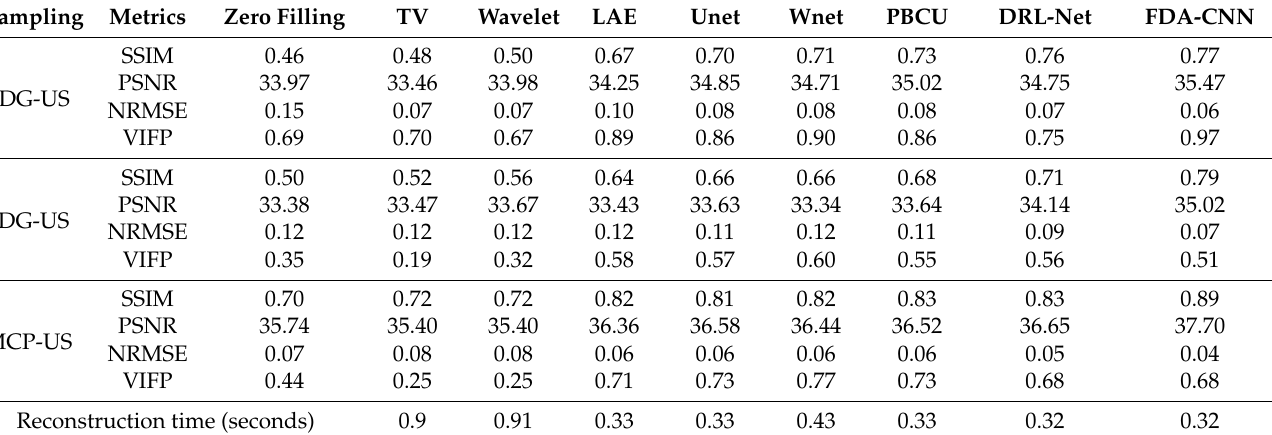
Table 3. Average SSIM, PSNR, NRMSE, and VIFP values and reconstruction time of state-of-the-art methods on the IXI -T2 coronal dataset using several sampling